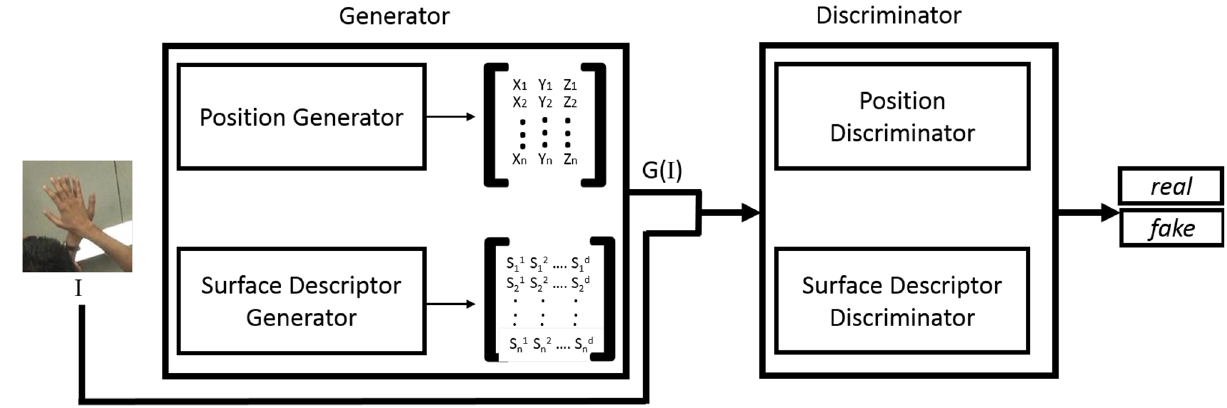
Figure 1. The proposed Im2Mesh GAN architecture for coupled training data. The position values and the SHOT descriptor values are generated using the generator network and passed to the discriminator network, which classifies whether they are generated or the groundtruth.